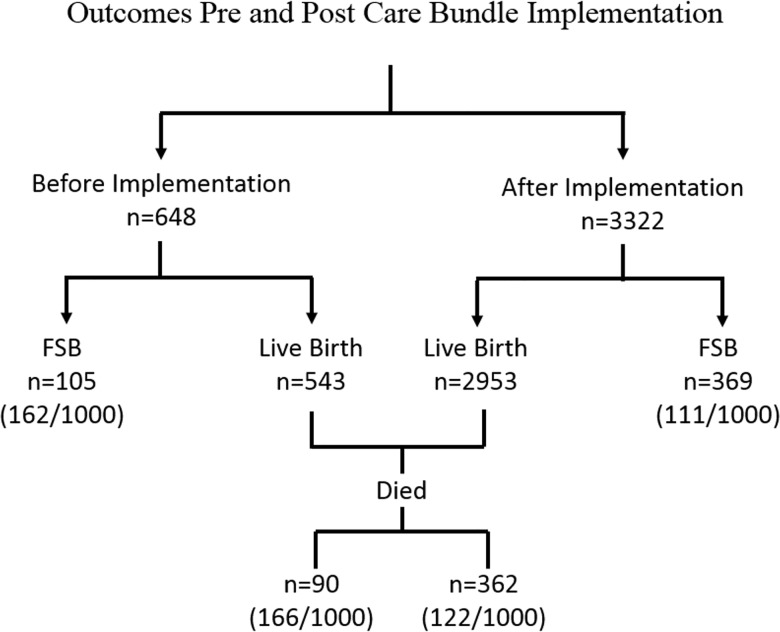
Outcomes pre and post implementation.